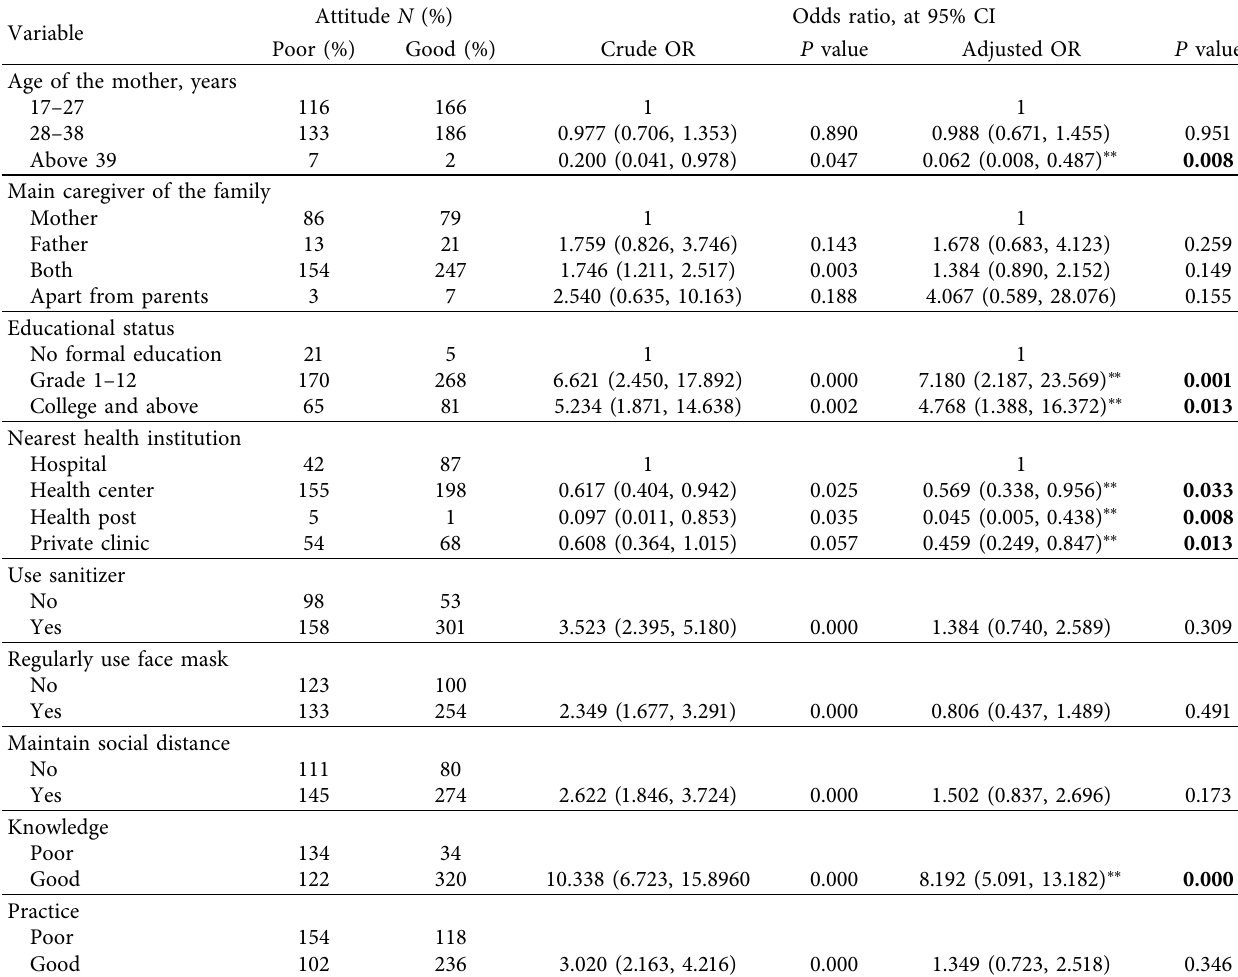
Table 7: Factors associated with the attitude of mothers towards COVID-19 in Dessie town, Ethiopia, 2020.